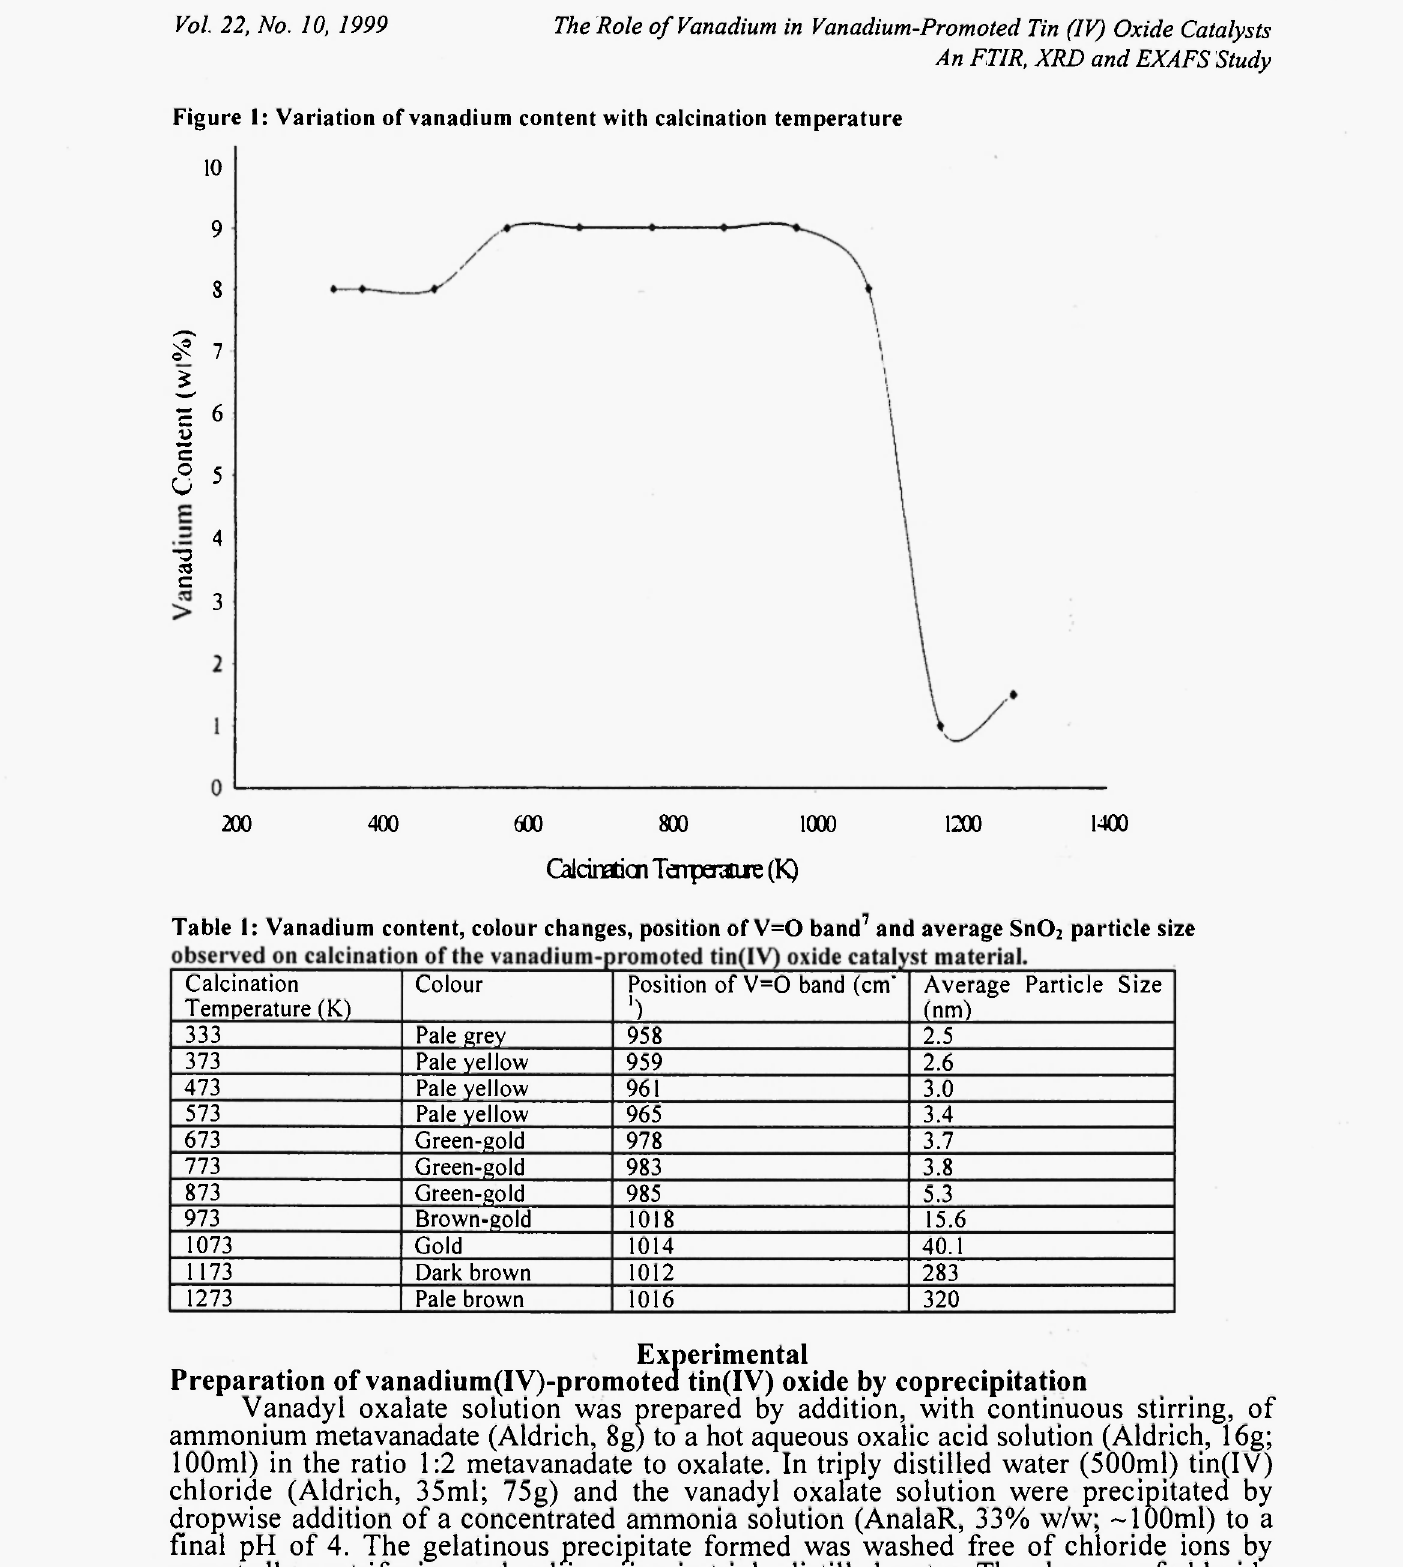
Table 1: Vanadium content, colour changes, position of V =0 band 7 and average Sn0 2 particle size Calcination Colour Position of V=0 band (cm" Temperature (K)